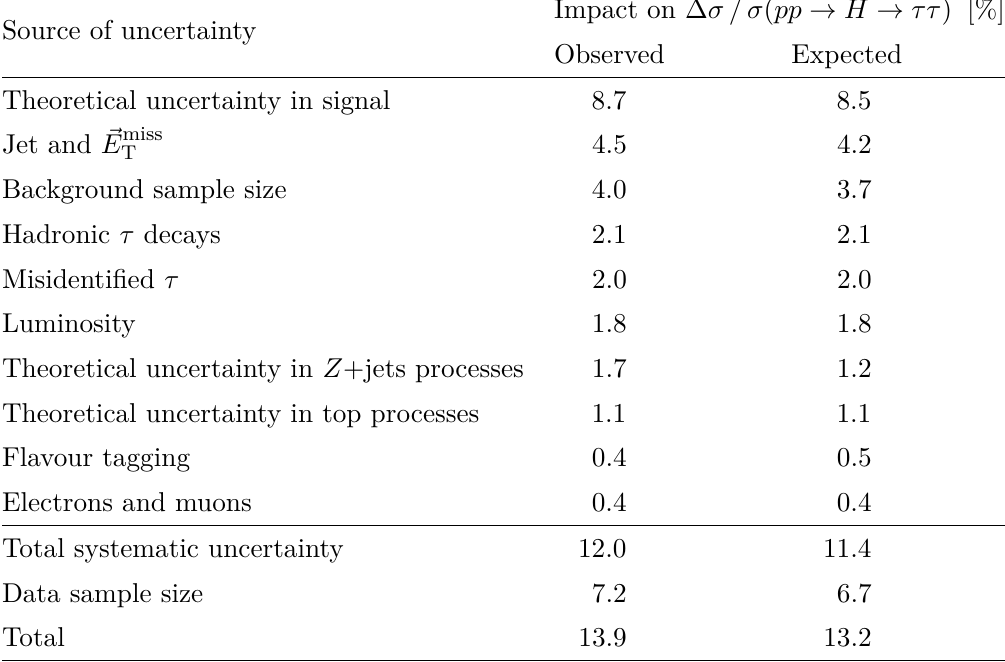
Table 7. Summary of the different sources of uncertainty in decreasing order of their impact on σ ( pp → H → ττ ) . Their observed and expected fractional impacts, both computed by the fit, are given, relative to the σ ( pp → H → ττ ) value. Experimental uncertainties for reconstructed objects combine efficiency and energy/momentum scale and resolution uncertainties. Background sample size includes the bin-by-bin statistical uncertainties in the simulated backgrounds as well as statistical uncertainties in misidentified τ backgrounds, which are estimated using